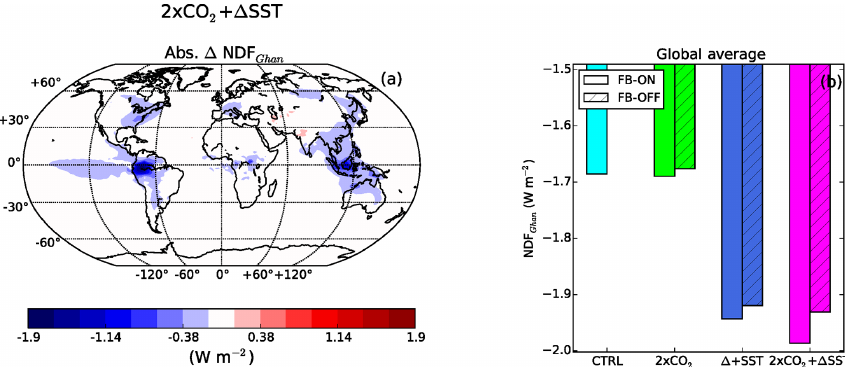
Figure 11. The absolute difference between the FB-ON and FB-OFF simulations in the annual average NDF Ghan (a) for the 2 × CO 2 + (cid:49) SST experiment. In panel (b) , the globally averaged NDF Ghan for the CTRL simulation as well as the three experiments (both FB-ON and FB-OFF simulations) are shown.